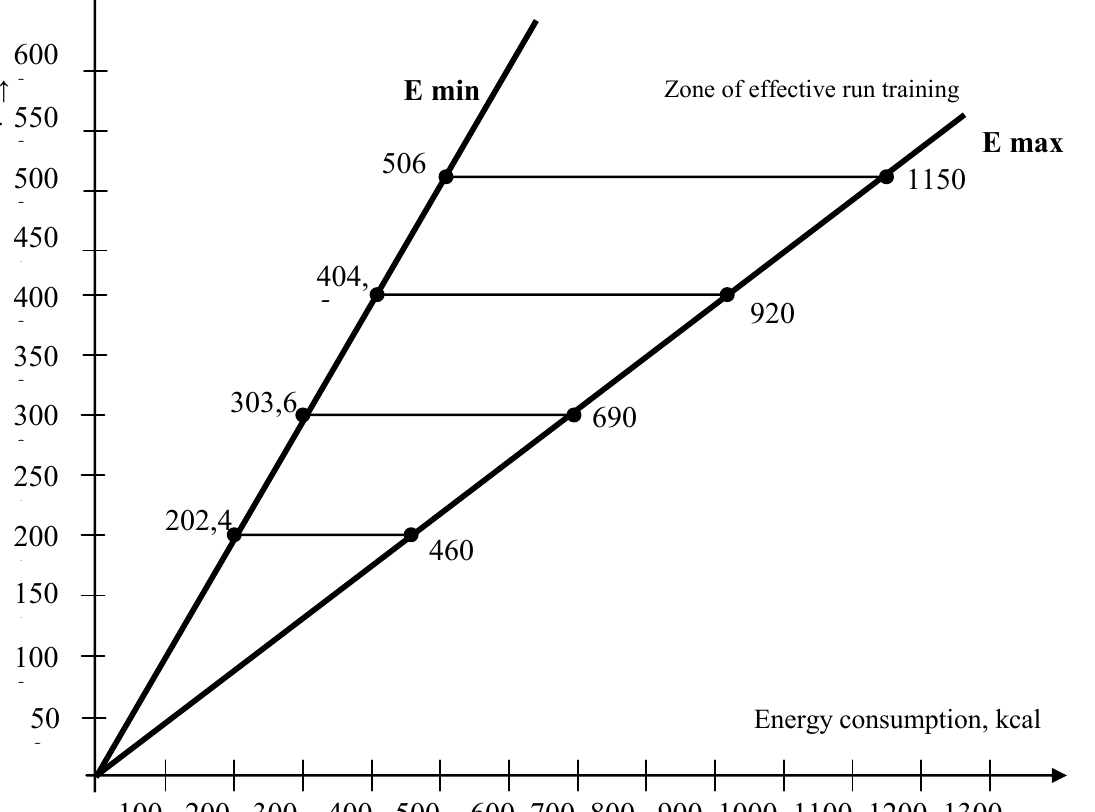
Fig. 3. Optimal range of energy consumption depending upon the value of maximal oxygen consumption (VO 2 max ) E min is the line of minimal energy consumption E max is the line of maximal energy